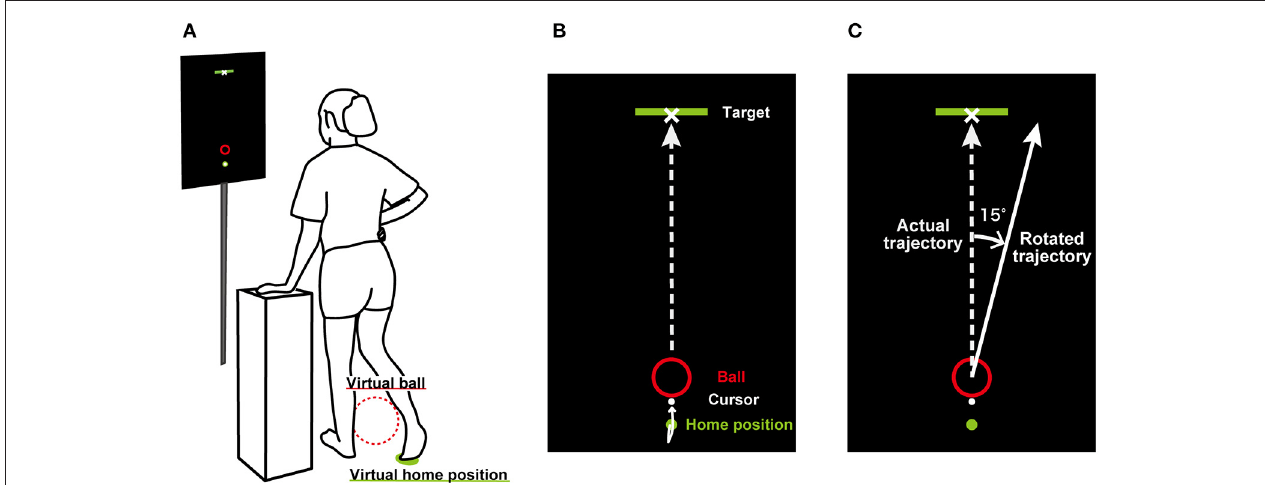
FIGURE 1 | Experimental setup. (A) shows how participants performed a ball-kicking task. They swung their right leg while standing with their right hand on their hip and their left hand comfortably placed on a table. They were asked to swing their right foot and kick a virtual ball in the display so that the virtual ball could hit the target. (B) illustrates the display shown in front of the participants. On the screen, the locations of the target, virtual ball, home position, and cursor on the horizontal plane were displayed. The virtual ball moved in constant velocity linear motion depending on the kicking position and the right foot velocity. (C) shows the rotated trajectory during the perturbation